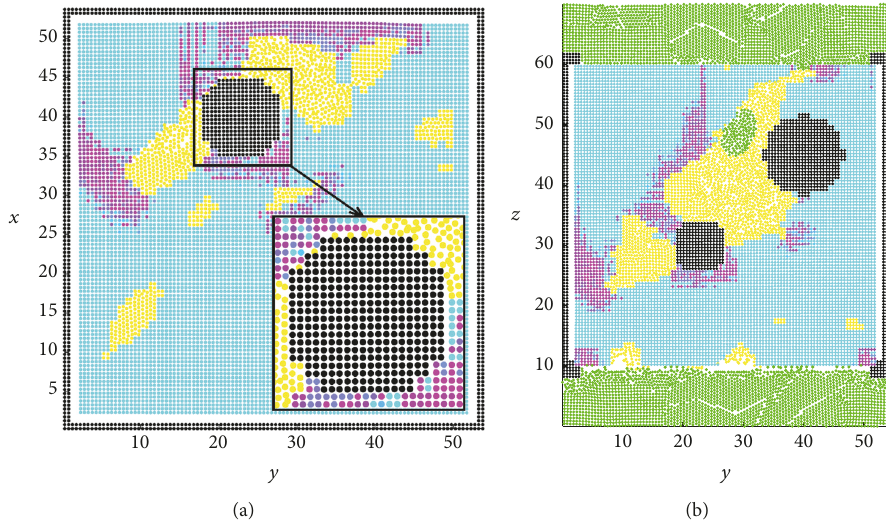
∼ 6 MPa at 𝑡 = 12s. Two conf